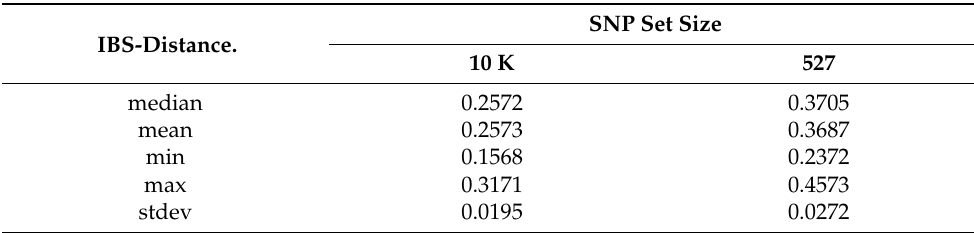
Table 2. Median values of statistical properties of genotype distance distribution for two single nucleotide polymorphism (SNP)